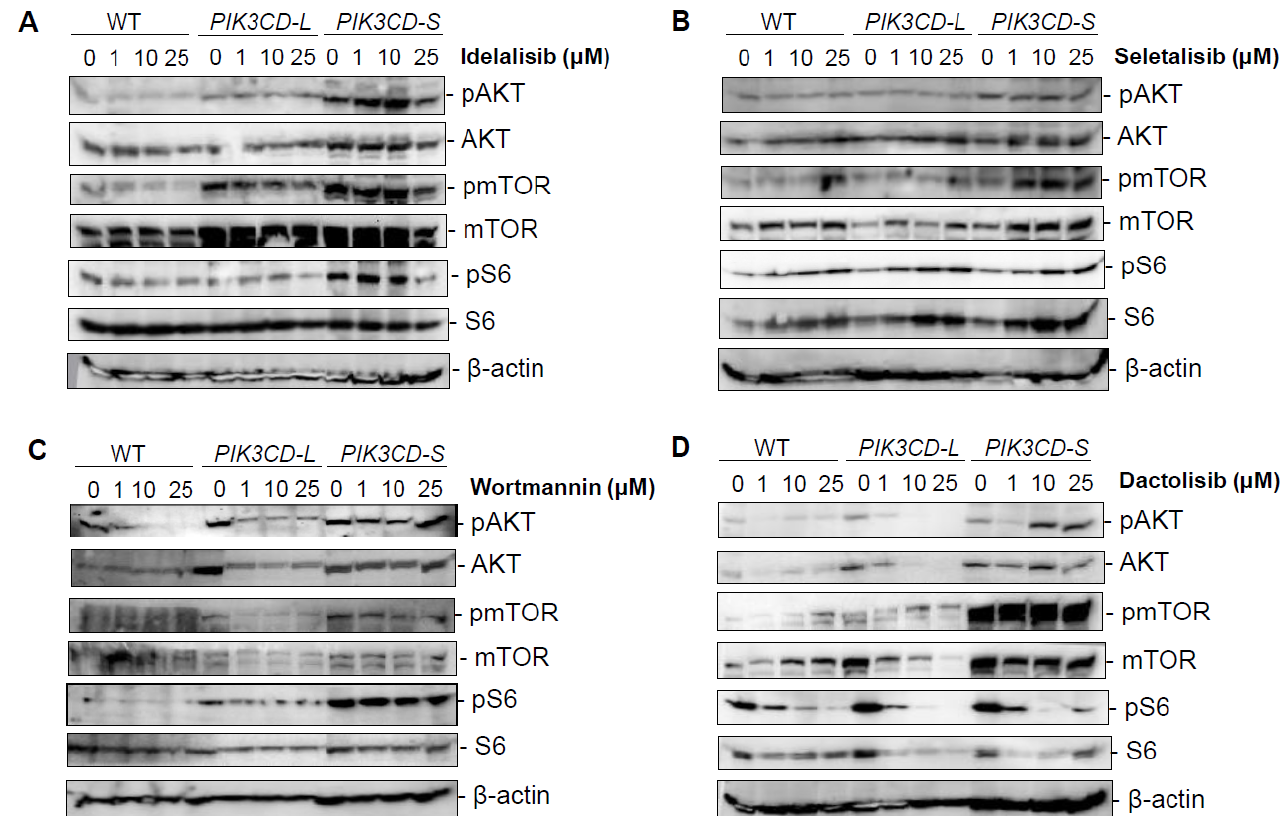
Figure 4. Inhibitory effects on PI3K/AKT/mTOR signaling in PCa cells overexpressing PIK3CD-L and PIK3CD-S variants in response to pan-PI3K, PI3K δ , and PI3K/mTOR dual inhibitors. Western blot analysis of pAKT, AKT, pmTOR, mTOR, pS6, and S6 in MDA PCa 2b cells stably expressing PIK3CD-L and PIK3CD-S in presence of ( A ) Idelalisib, ( B ) Seletalisib, ( C ) Wortmannin, and ( D ) Dactolisib at concentrations of 0, 1, 10, and 25 µM. β -actin was served as an endogenous protein control.